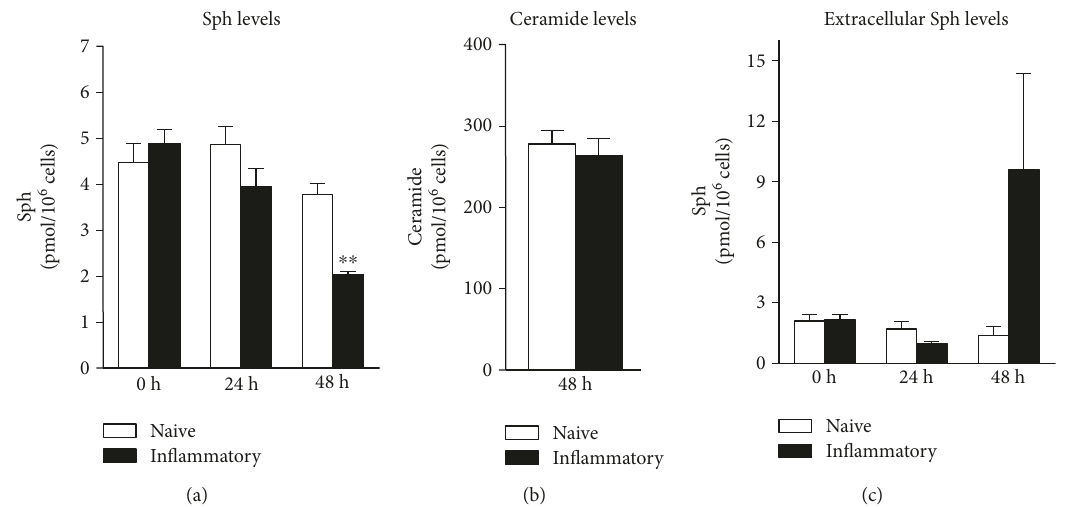
Figure 4: Quanti fi cation of sphingolipids and ceramides with LS-MS/MS normalized to 10 6 cells (a) intracellular sphingosine levels, (b) intracellular ceramide levels (C14-C24), and (c) extracellular sphingosine levels ( n = 4 ). Data represent mean ± SD; ∗∗ p ≤ 0 01